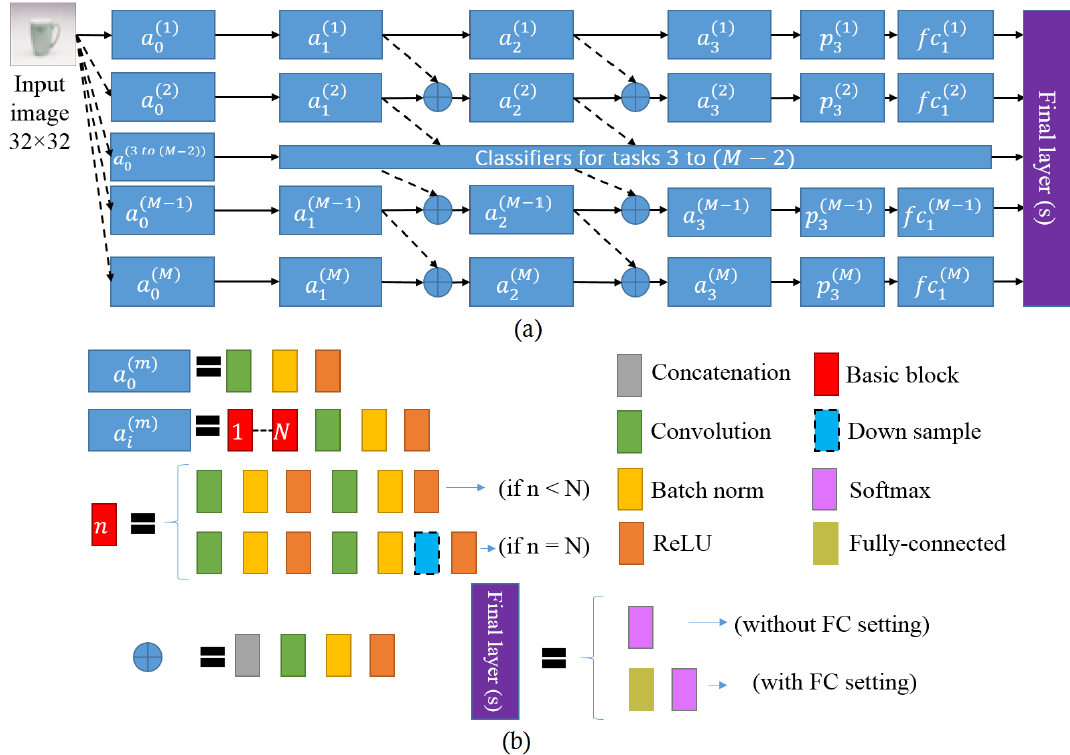
Figure 1. Proposed architecture of the progressive network for incremental learning. ( a ) Each row represents an additional classifier (AC) trained on task ‘m’. ( b ) The implementation details of the blocks used in ( a